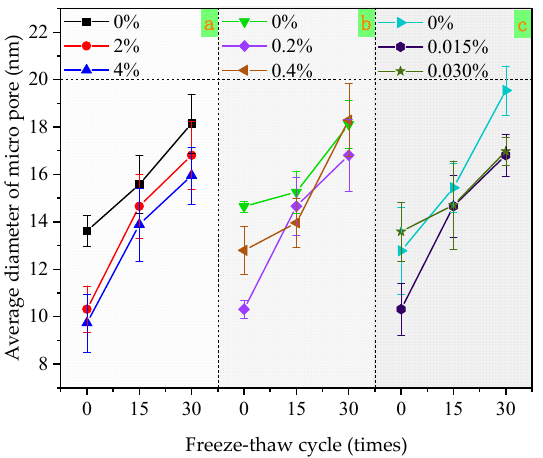
Figure 4. Influence of three factors on cumulative pore volume: ( a ) the factor of redispersible emulsion powder; ( b ) the factor of polypropylene fiber; ( c ) the factor of air-entraining agent.